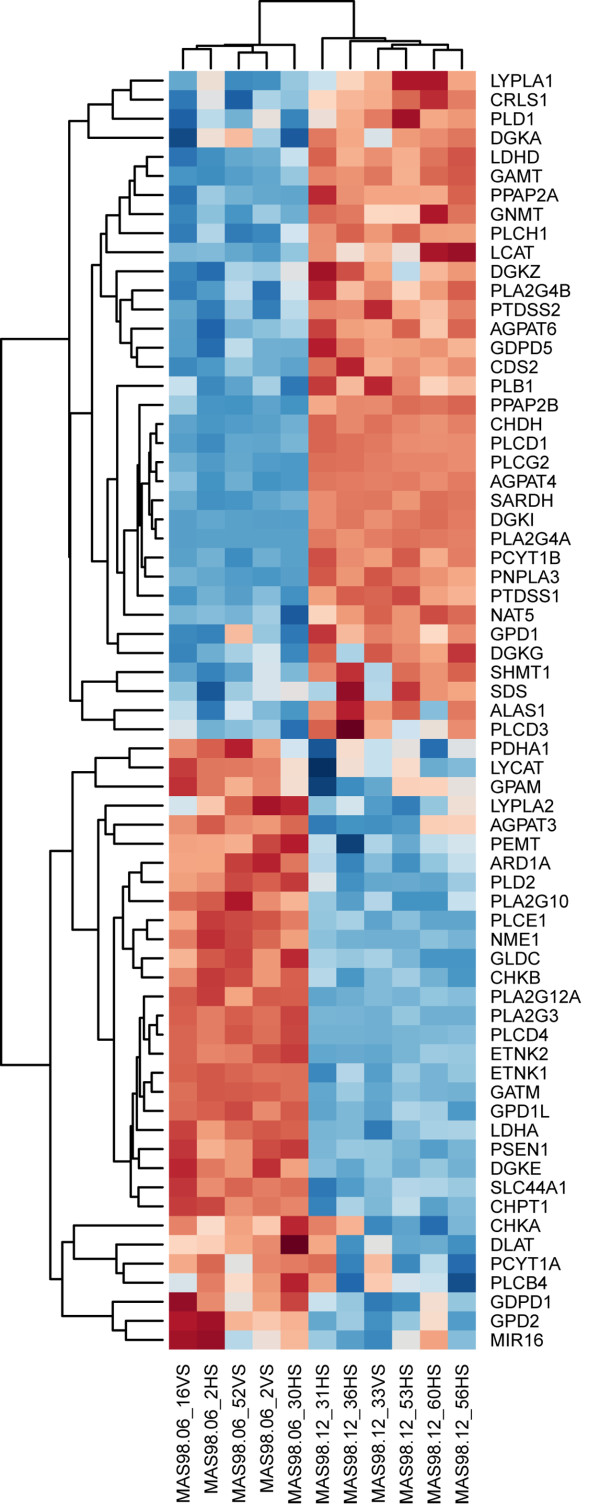
Heatmap of differentially expressed genes in xenograft models. Hierarchical clustering of the 67 differentially expressed genes (false discovery rate < 0.05) involved in the KEGG homo sapiens glycerophospholipid pathway hsa:00564, choline transport or directly involved in conversion from choline to glycine (Red: high expression compared to mean expression in xenograft samples. Blue: low expression compared to mean expression in xenograft samples). The microarray data was centred across genes and clustered across genes and samples using Euclidian distance and complete linkage.